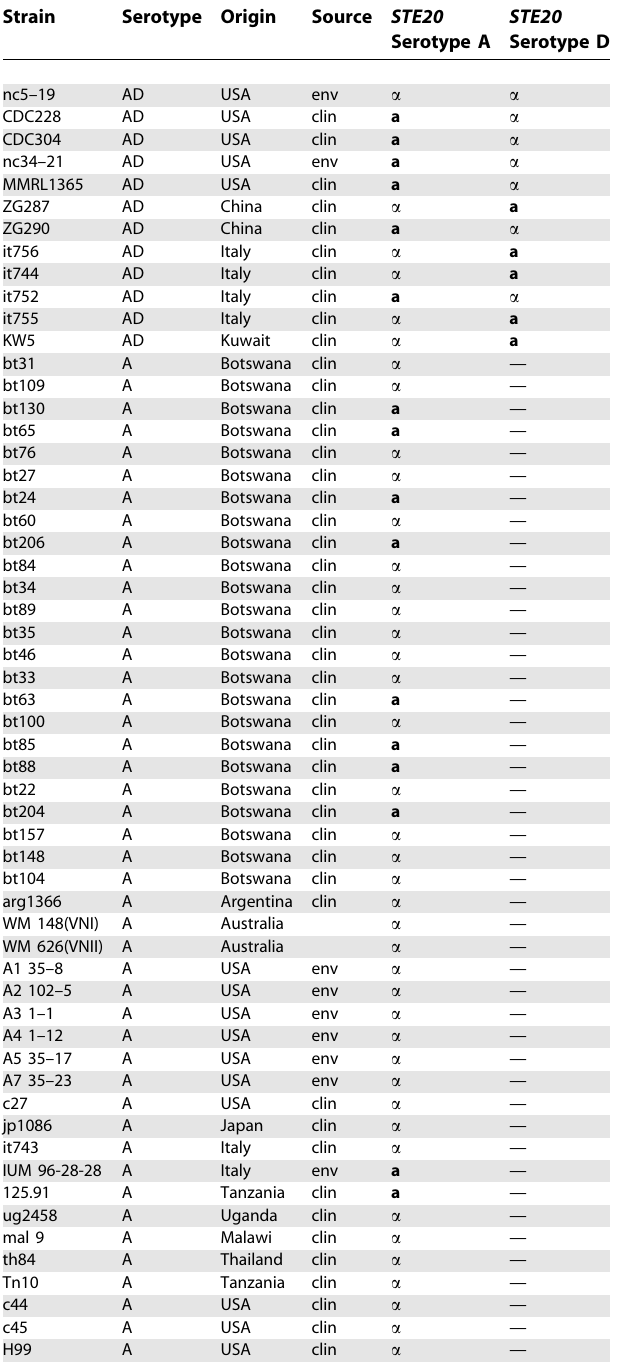
Table 1. Strains of Cryptococcus neoformans Used in This Study Table 2. DNA Identity between Portions of STE20 of Different